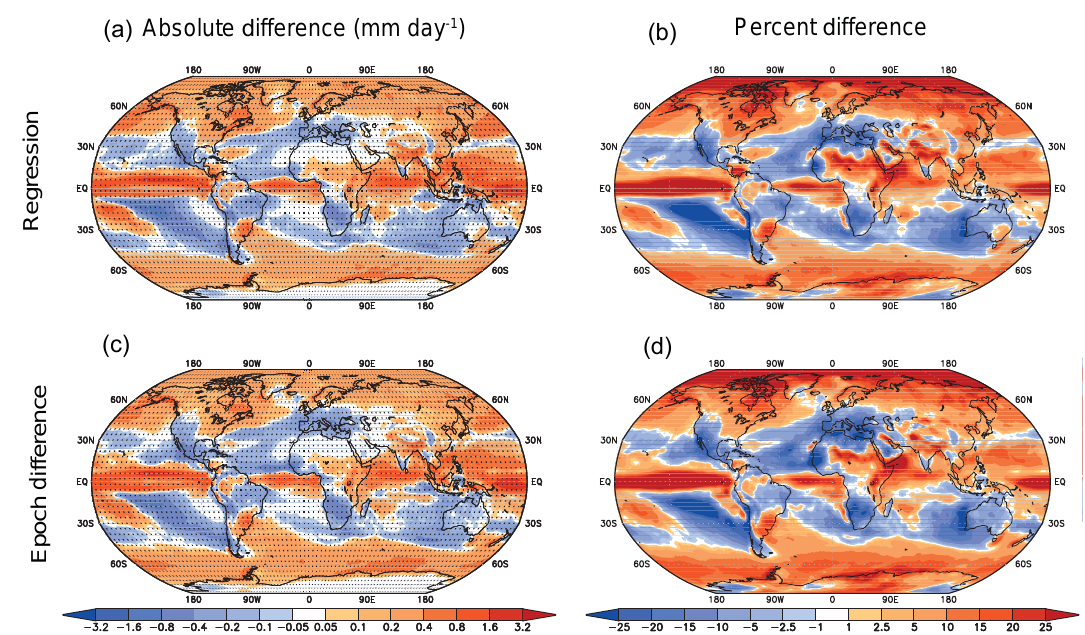
(cid:49) ¯ T RCP2 . 6 , nonCO (227–251) + P 1pctCO2 (cid:49) ¯ T RCP2 . 6 , CO 2 2